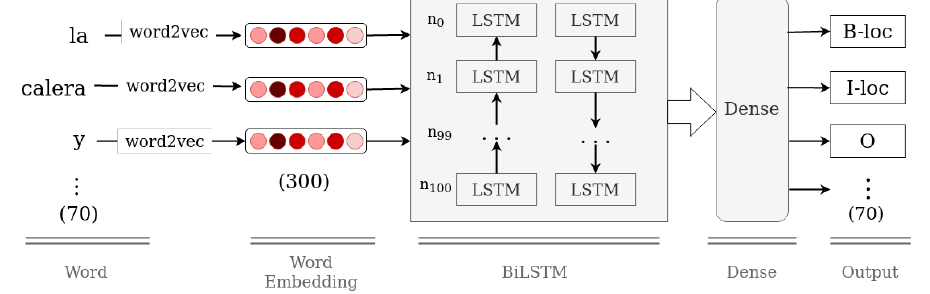
Figure 5. Sequence labeling using BiLSTM